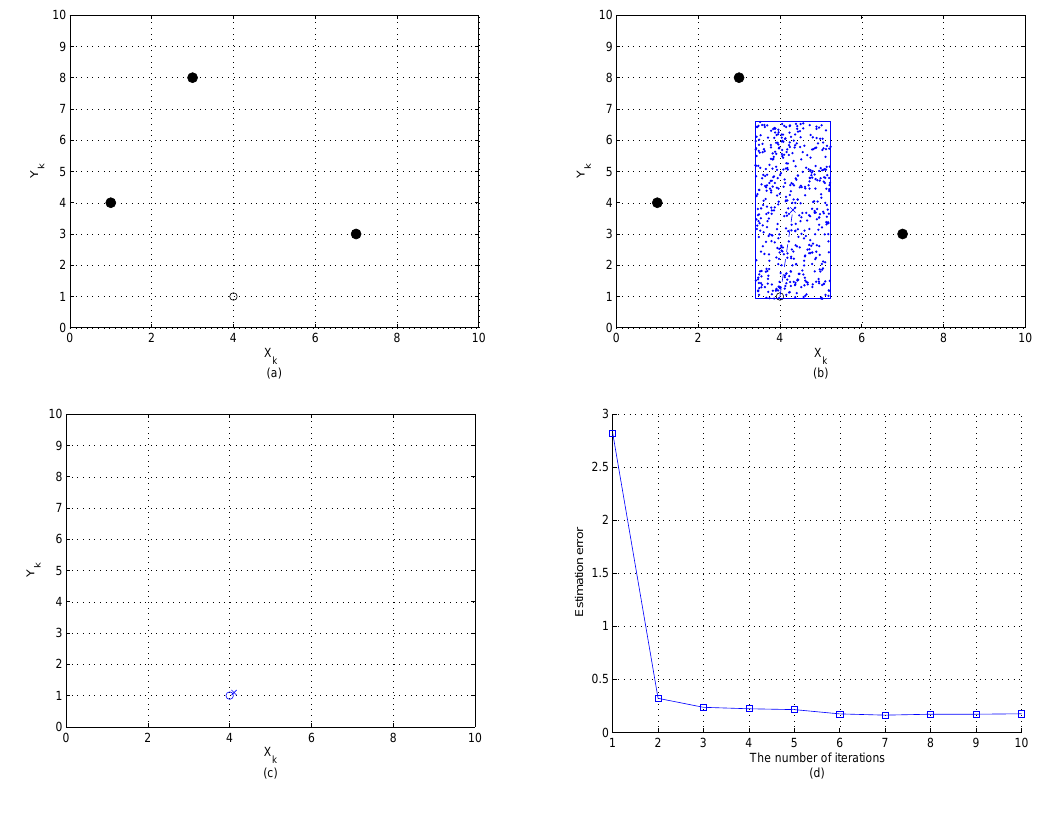
Figure 8. Using particle filtering for initial position estimation. “ • ” represents the reference node, “ ◦ ” represents the unknown node, and “ × ” represents the initial estimated sensor